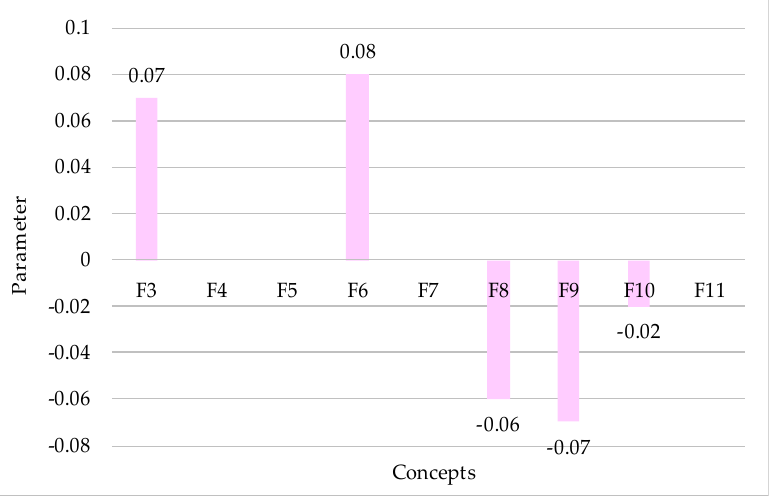
Concepts Figure 5. Scenario demonstrating the system response, with a complex maximum weakening of the impact of the most important threats. As a result of the analysis of this bar chart, it is possible to draw a conclusion that under the given conditions CN security will increase by 0.65 conditional units, i.e., by 65%. Thus, the developed fuzzy cognitive map of the analysis of the impact of threats on the level of network security reflects mainly the qualitative trends in the situation de-